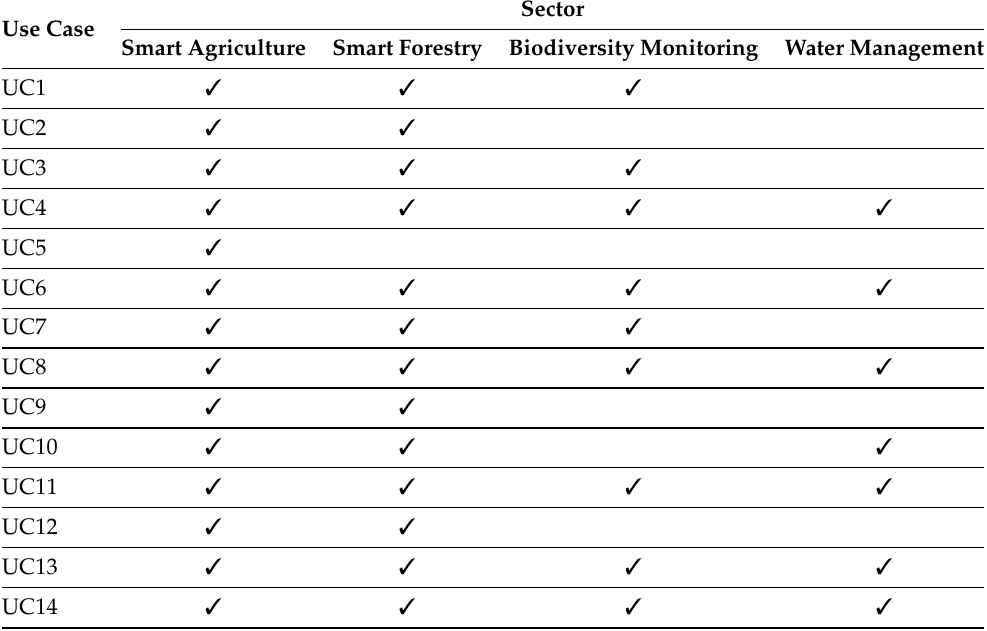
Table 1. Use cases by